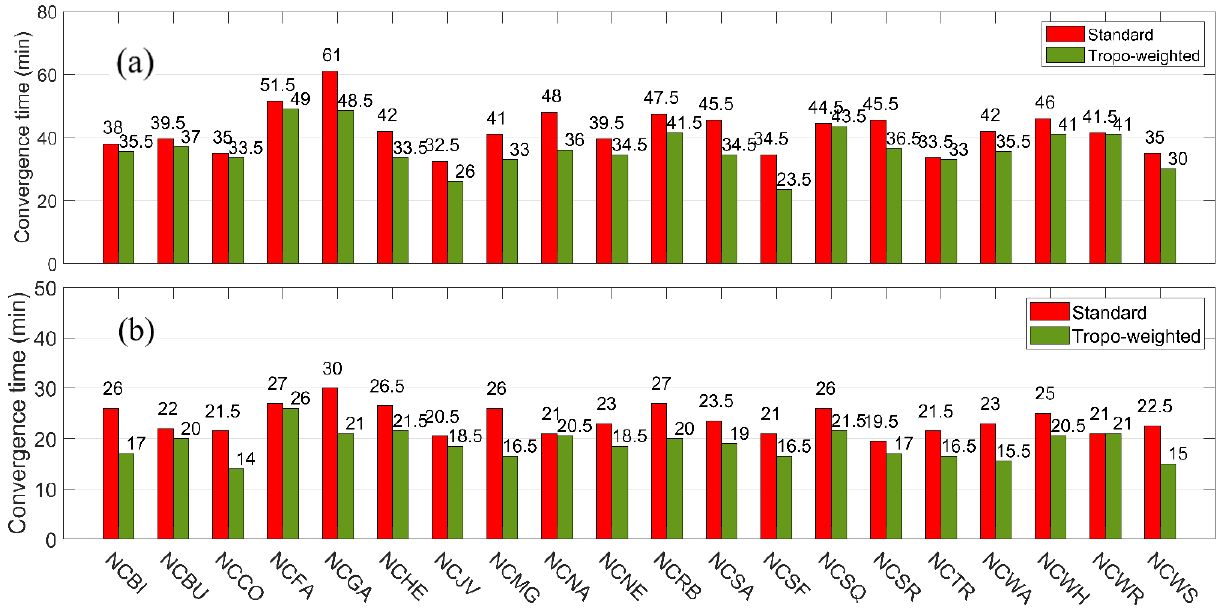
Figure 6. The convergence time of ( a ) the ambiguity-float kinematic positioning solution and ( b ) ambiguity-fixed kinematic positioning solution in terms of achieving 10 cm 3D positioning accuracy with 90% probability